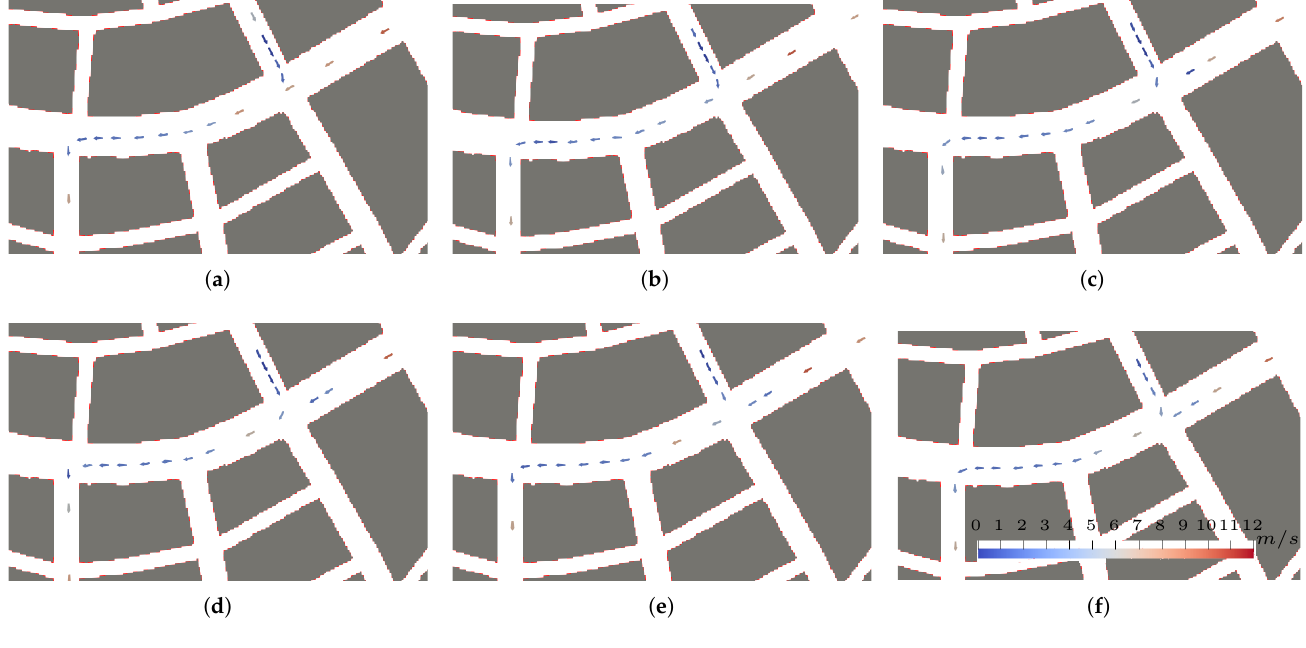
Figure 7. Snap shots of car agents at a merging junction and a sharp bend: ( a ) t = 0 s, ( b ) t = 3 s, ( c ) t = 5.4 s, ( d ) t = 7.4 s, ( e ) t = 10 s, ( f ) t = 12.8